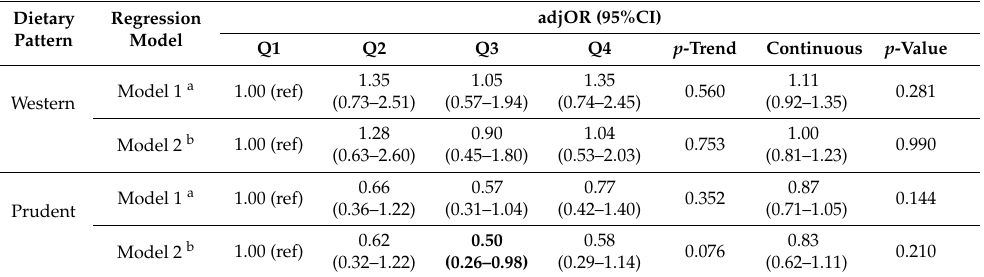
Table 6. Association between dietary patterns derived by principal component analysis and the risk of CIN2+.